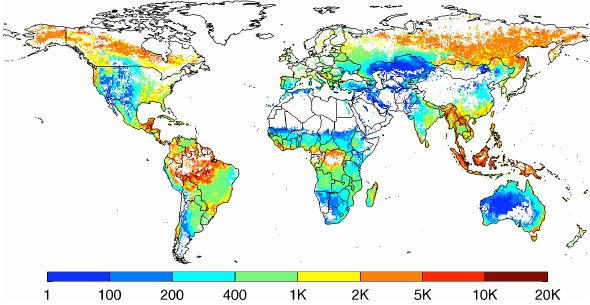
Fig. 6. Fuel consumption (g C per m 2 of area burned), averaged over 1997-2009.